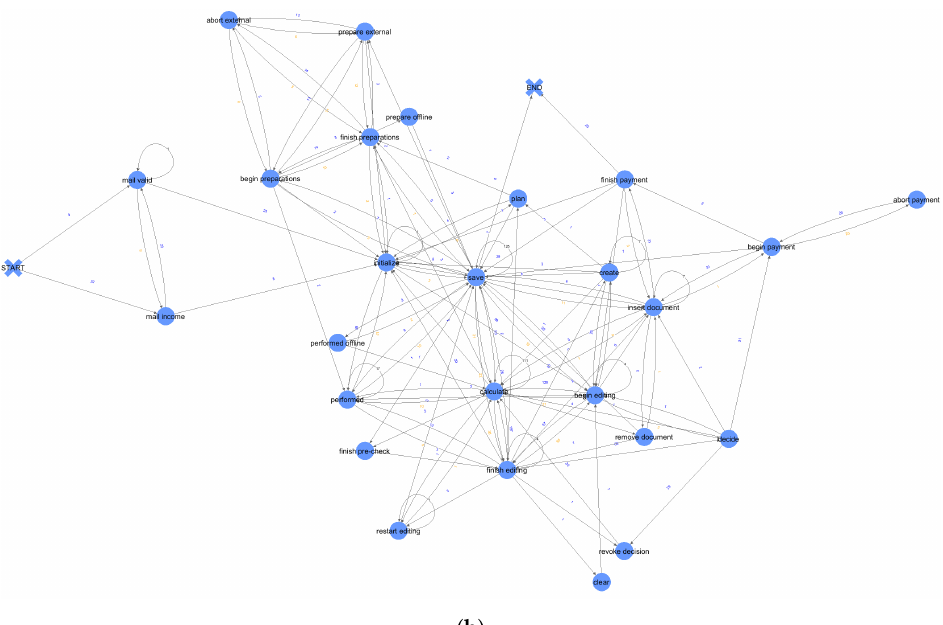
Figure 7. ( a ) Discovered work transference network and ( b ) its temporal workcase among the activities from 31 event traces (20,000th–20,030th).